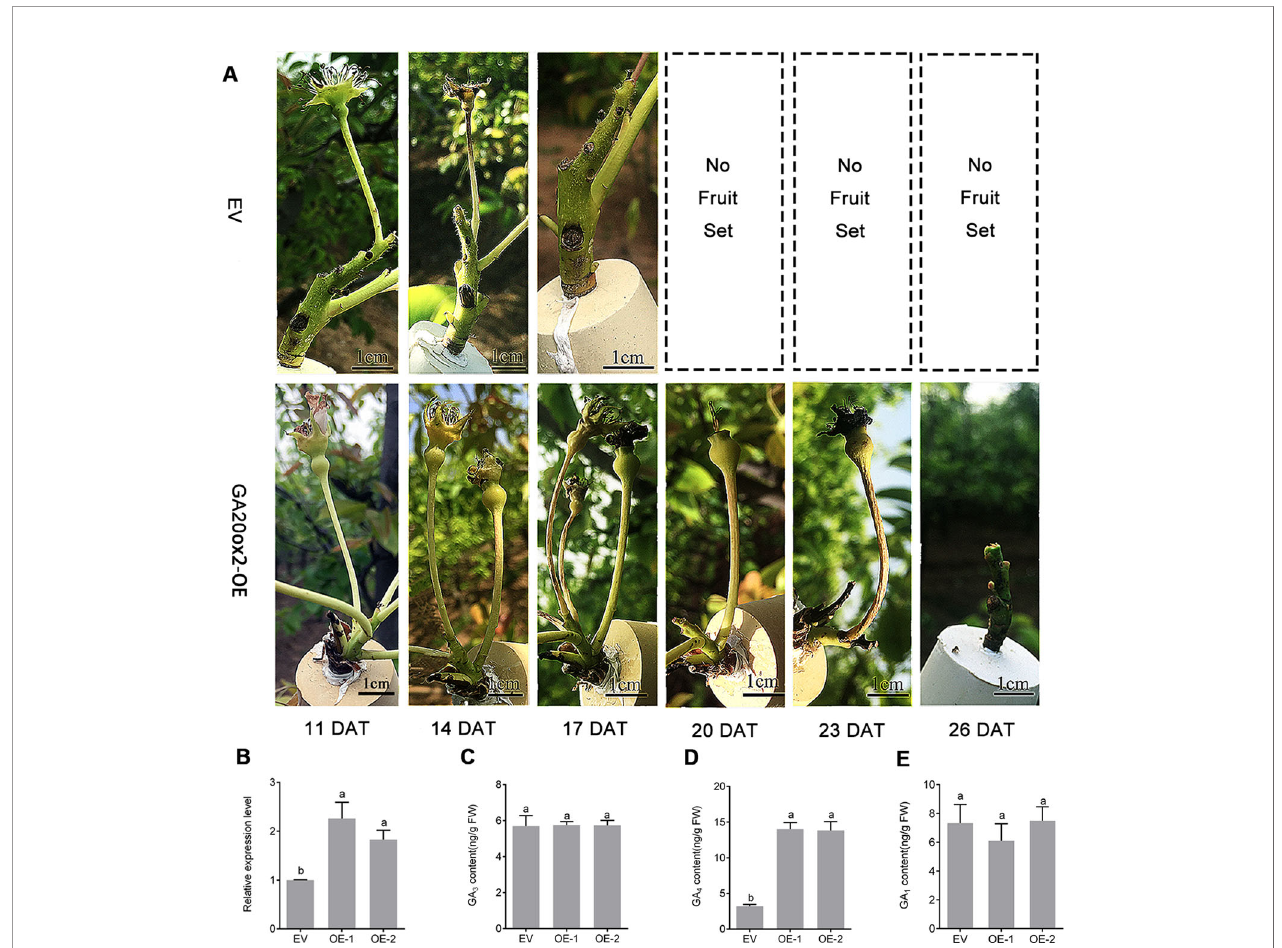
FIGURE 5 | Transient overexpression assay of PbGA20ox2 in ‘ Dangshansu' pear fruits. (A) Images of in fl orescence development on different days after the transient overexpression of PbGA20ox2 in ‘ Dangshansu' pear. (B) Relative expression levels of PbGA20ox2 in control (empty vector, EV) and two independent overexpressed lines. The expression level of the gene in fruits transformed with the EV was normalized to 1.0. (C – E) GA 3, GA 4 and GA 1 contents in pear fruits at 5 DAT. OE-1 and OE-2 represent two biological repeats with overexpressing PbGA20ox2 . Results are means ± SD ( n = 3). Different letters between bars indicate signi fi cant differences at P < 0.05 (Duncan's range test). DAT, days after